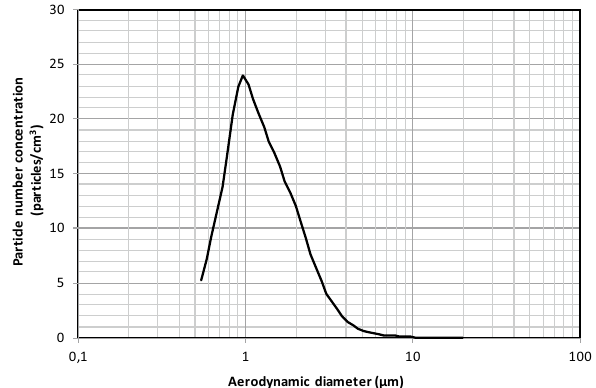
Figure 1. Size distribution of Holi particles.